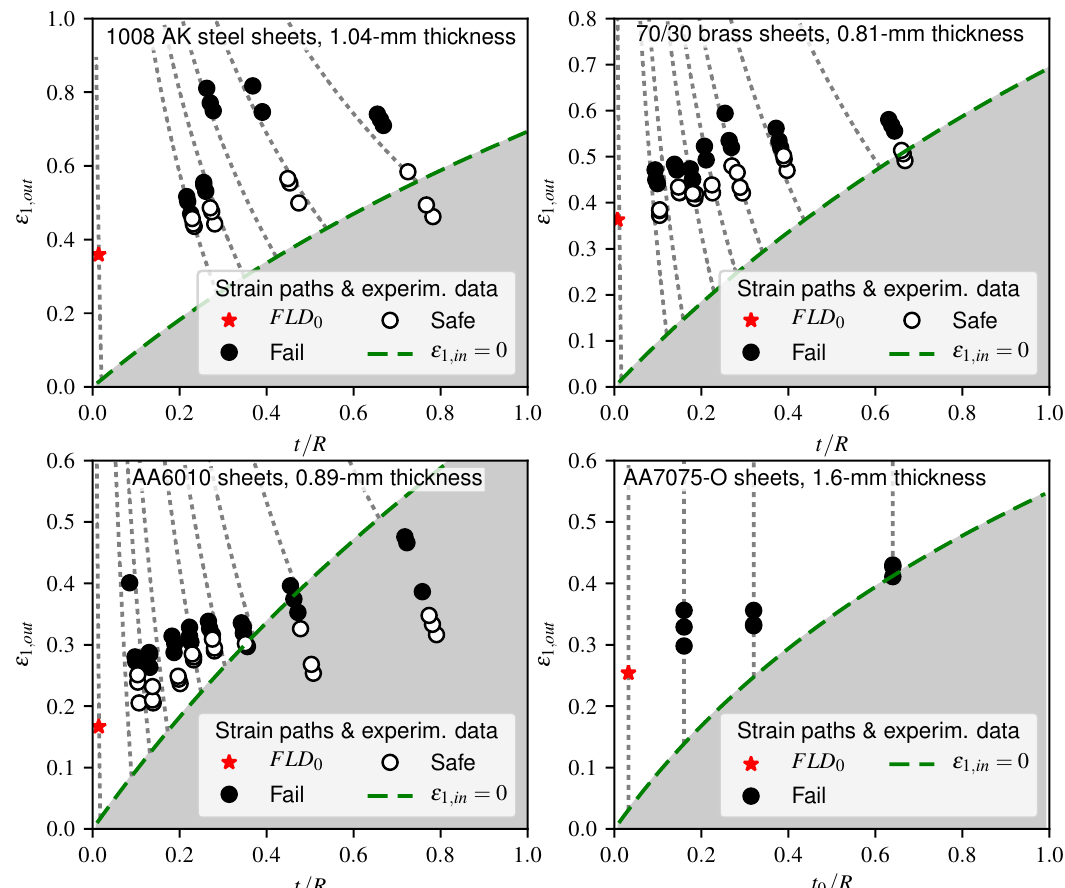
Figure 5. Influence of punch radius R on the formability of stretch-bent 1008 AK steel, 70/30 brass, AA6010 and AA7075-O